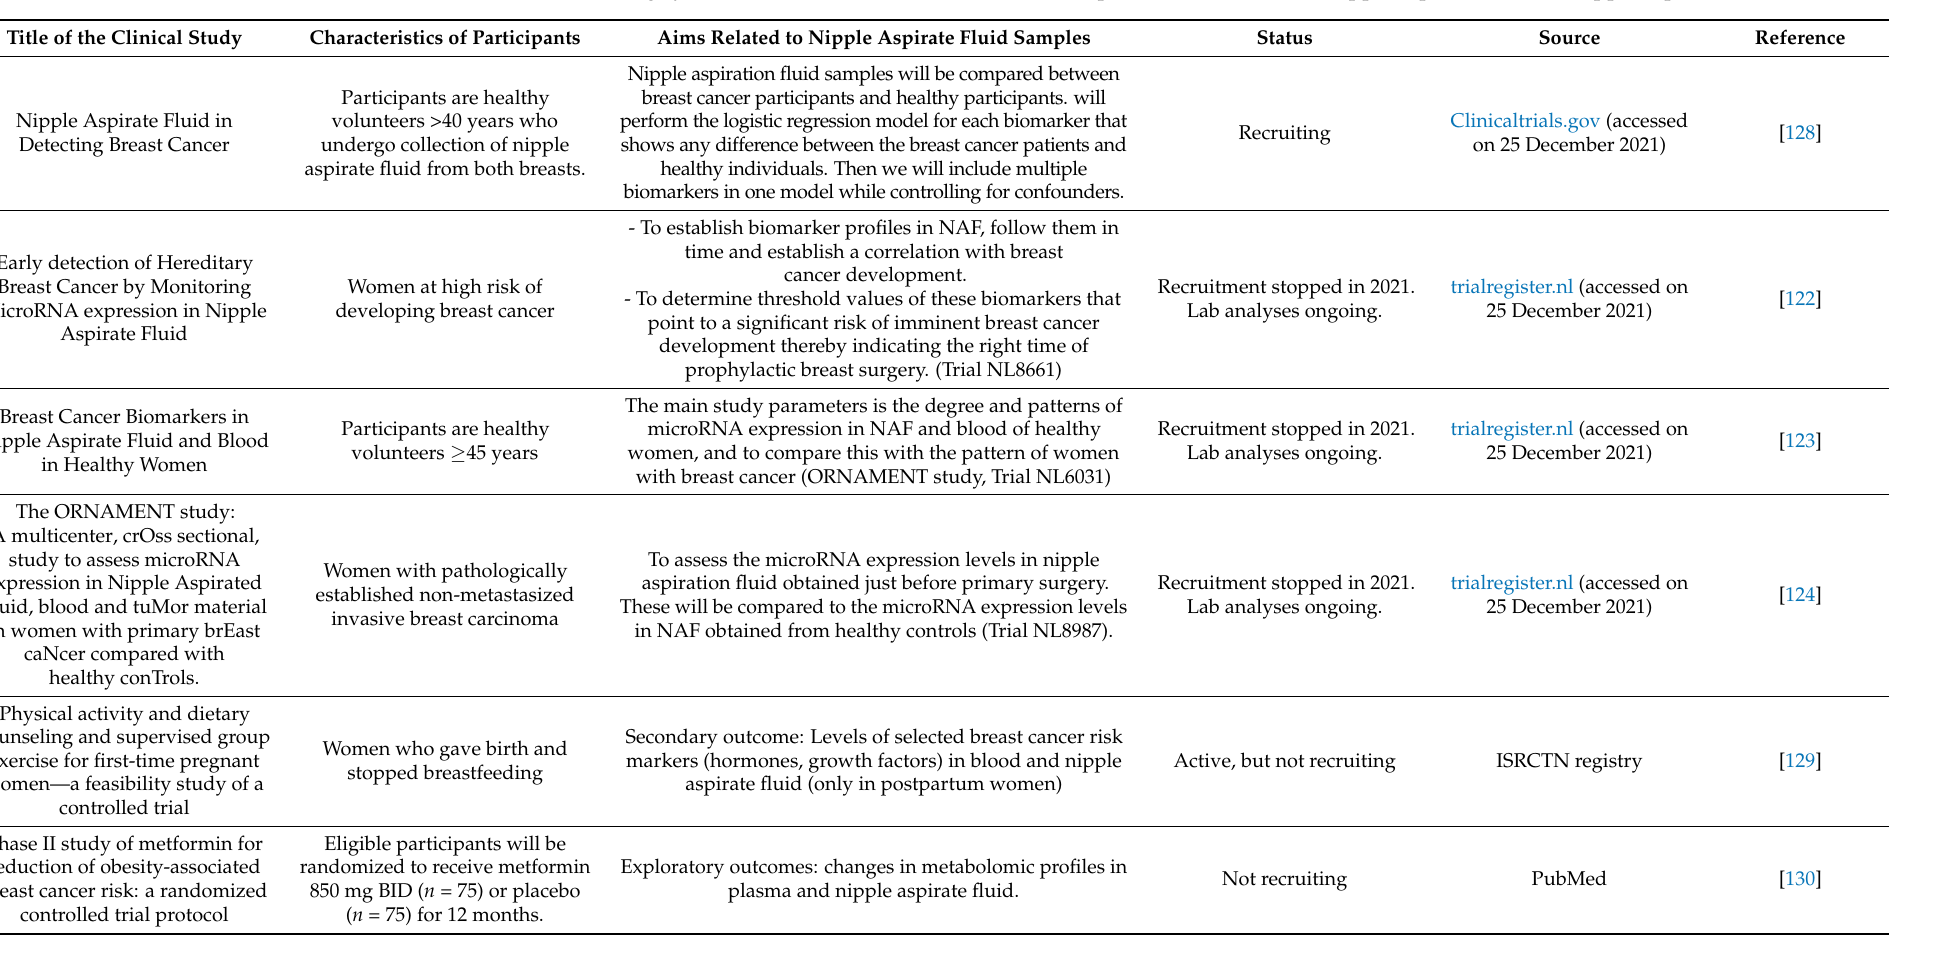
Table 3. List of registered trials on nipple aspiration fluid identified by searches in https://clinicaltrials.gov/, accessed on 25 December 2021. Trialregister.nl, ISRCTN and PubMed. The following syntax was used for a search on Pubmed: (“protocol”[Title]) AND (nipple aspirate fluid OR nipple aspirate